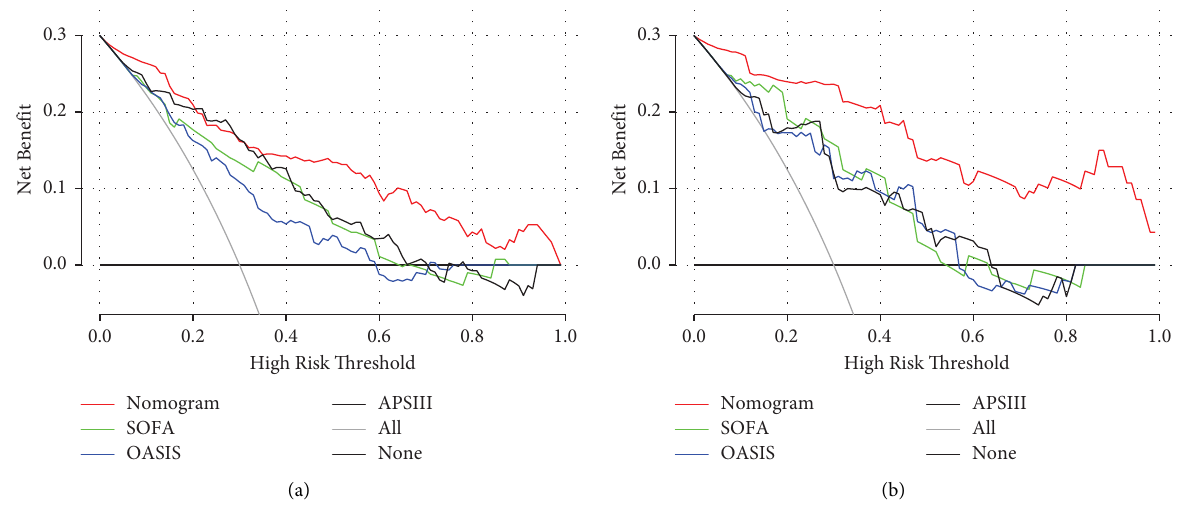
Figure 5: Te decision curve analysis curves of medical intervention in patients with the nomogram, SOFA, OASIS, and APS III in the training cohort (a) and validation cohort (b). In both groups, the nomogram had superior standardized net beneft over SOFA, OASIS, and APS